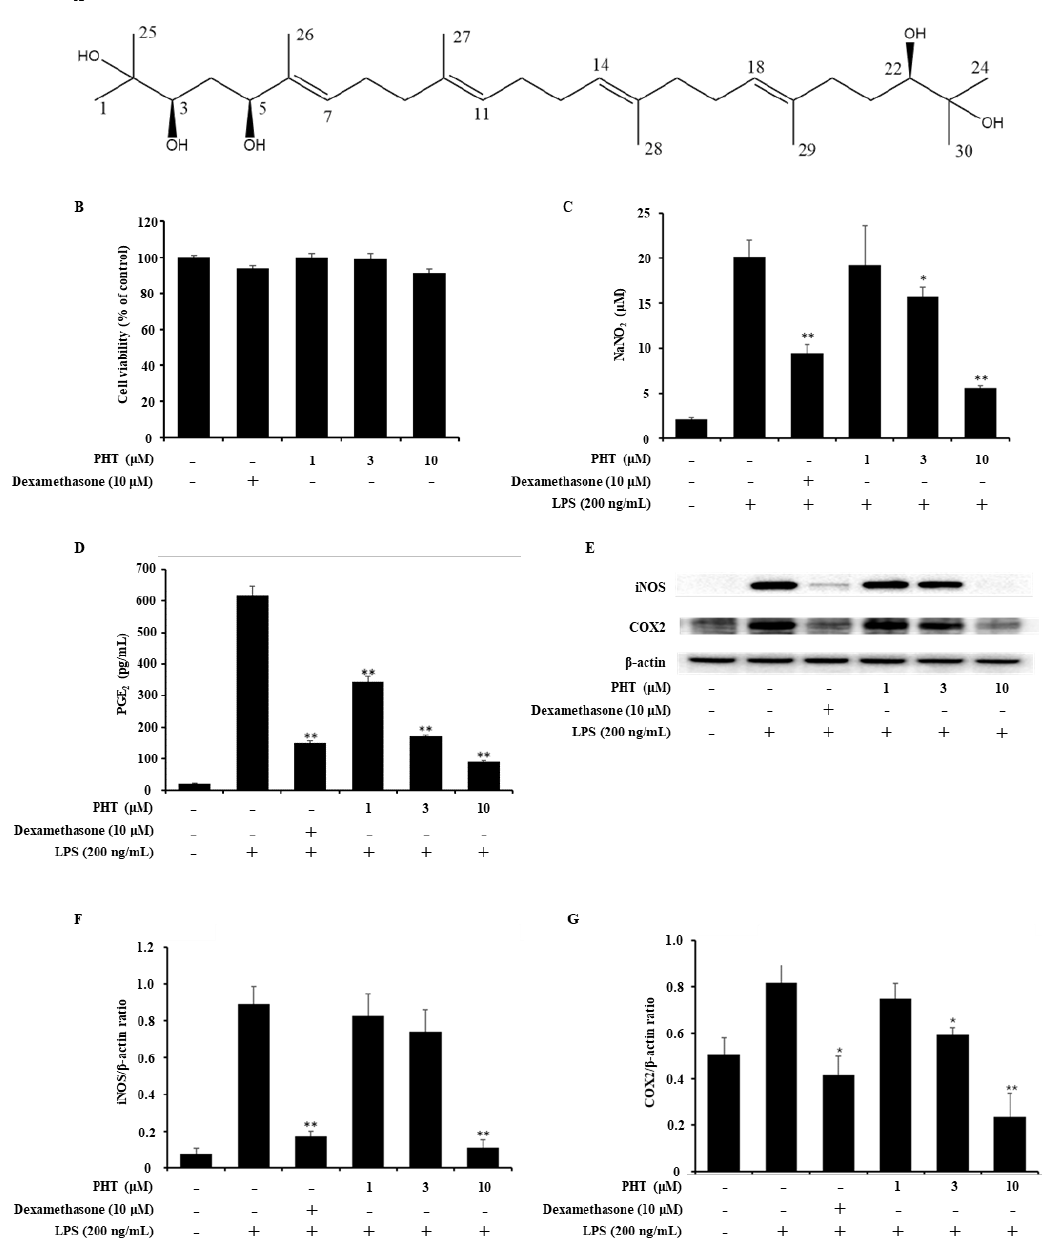
Figure 1. Effects of PHT on LPS-induced NO and PGE2 secretion and iNOS and COX2 protein expression in J774 cells. ( A ) Chemical structure of PHT. ( B ) Cytotoxicity of PHT. J774 cells were treated with 10 µ M dexamethasone or 1, 3 or 10 µ M PHT for 24 h. Cytotoxicity was determined by the MTT assay. ( C , D ) Inhibition of NO and PGE2 production by PHT. J774 cells were treated with LPS (200 ng / mL) for 18 h after pretreatment with 10 µ M dexamethasone or 1, 3, or 10 µ M PHT for 1 h. ( C ) The concentration of NO was measured by the NO assay using Griess reagents. ( D ) The level of secreted PGE2 was determined by ELISA. ( E – G ) PHT treatment decreased iNOS and COX2 protein expression. J774 cells were pretreated with dexamethasone and PHT for 1 h before LPS (200 ng / mL) treatment for 18 h. ( E ) Protein expression levels of iNOS and COX2 were measured by immunoblot assays. The band optical densities of ( F ) iNOS and ( G ) COX2 were calculated by ImageJ software. The immunoblot data are representative of three independent experiments. The values are presented as the mean ± SD of three individual experiments. * p < 0.05, ** p < 0.01 compared with the LPS-alone